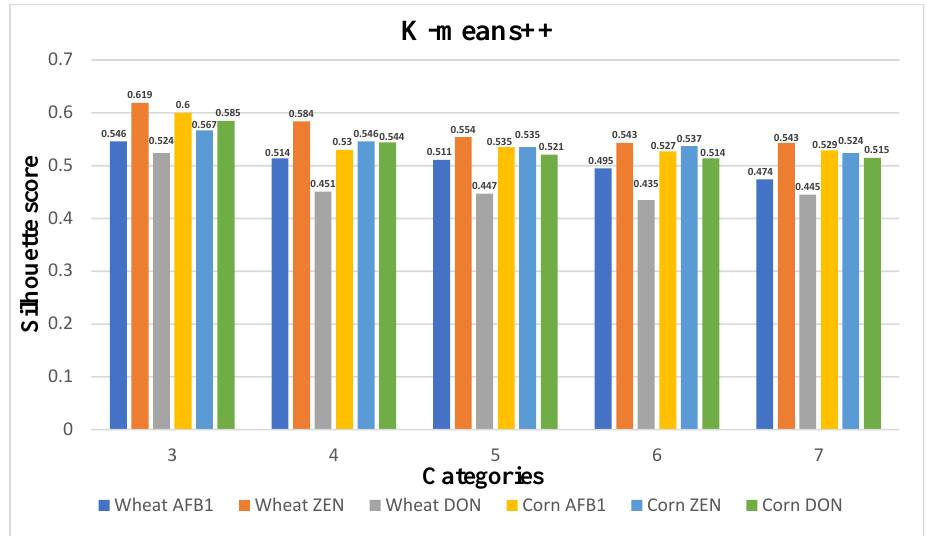
Figure 6. K-means++; 5 types of clustering category profile coefficients. Figure 7 plots the clustering results of K-means for wheat and maize with their cor- responding three toxins. Compared with K-means++, the contour coefficients of each cluster are generally lower than the results of K-means++, and the contour coefficients of three clusters are still the maximum.